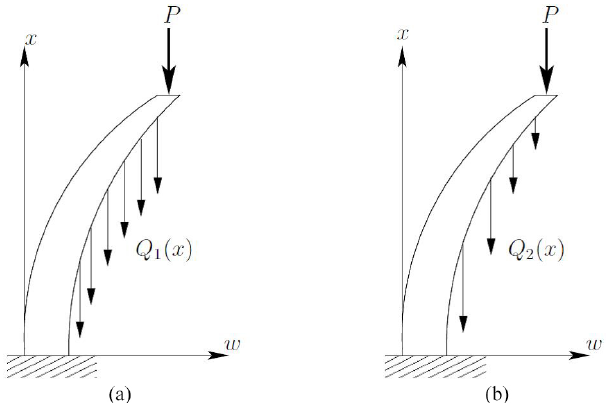
Figure 1. Clamped-free columns under tip loads and distributed ax- ial loads, (a) uniformly distributed load, (b) triangularly distributed